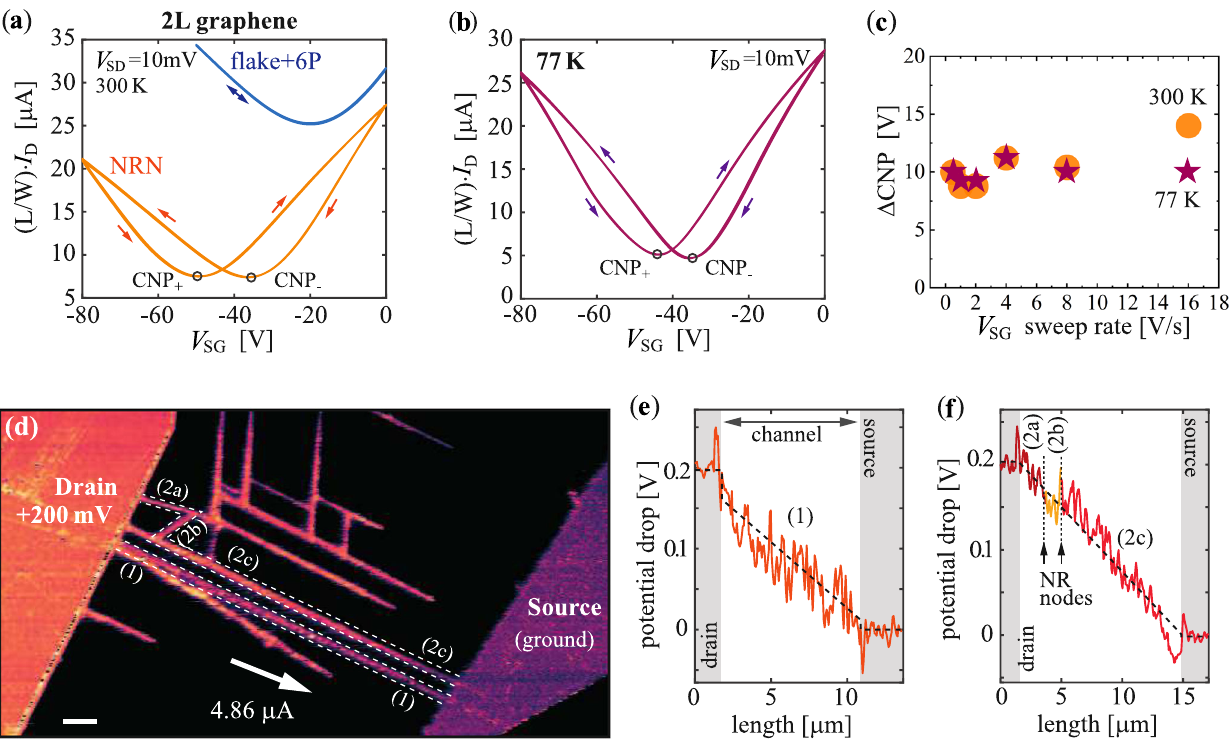
Fig. 5 Graphene NRN-FETs. a Length and width scaled transfer curves of the bi-layer graphene fl ake after organic nanostructure growth, and of the corresponding NRN-FET after annealing. Forward and reverse sweep direction is indicated by the arrows. b Length and width scaled transfer curves for graphene NRN-FET at 77 K, demonstrating that bi-modal switching persists at low temperature. c Difference in the forward and reverse bias charge neutrality point (CNP) positions as a function of the V SG sweeping rate. d in operando FM-KPFM image of a graphene NRN-FET (scale-bar: 1 μ m). Potential pro fi le lines from the ribbons indicated by (1) and (2a – c) in sub-panel d are presented in e and f ,